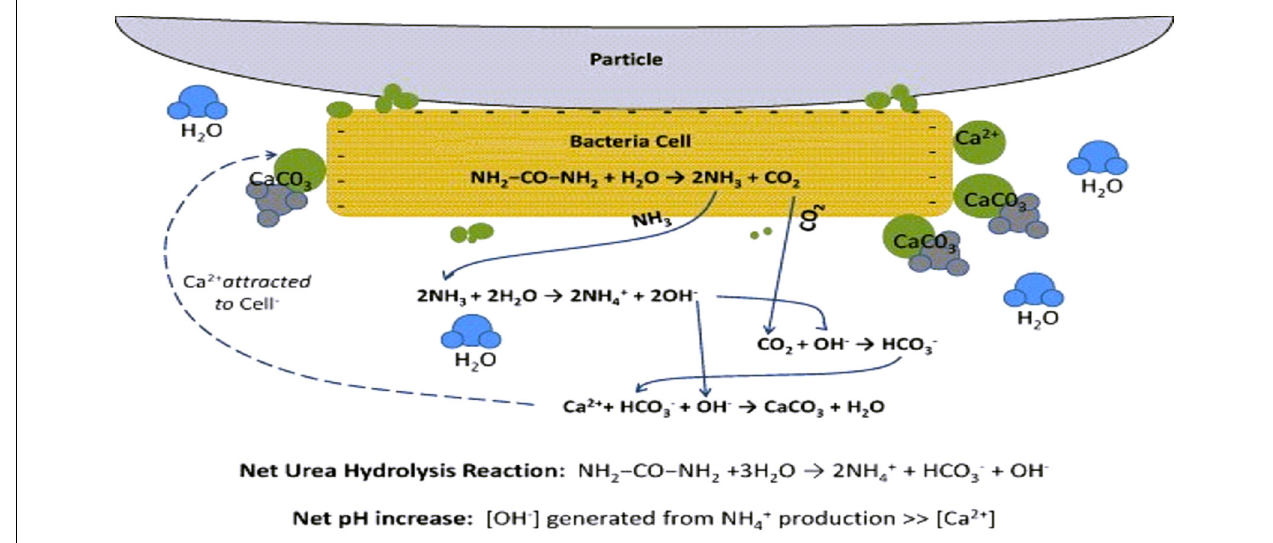
FIGURE 1 | Bacteria serving as nucleation site for CaCO 3 precipitation in the substrate particles. Calcium ions in the solution are attracted to the bacterial cell wall due to its negative charge. When urea is added to bacteria, dissolved inorganic carbon (DIC) and ammonium (AMM) are released in the